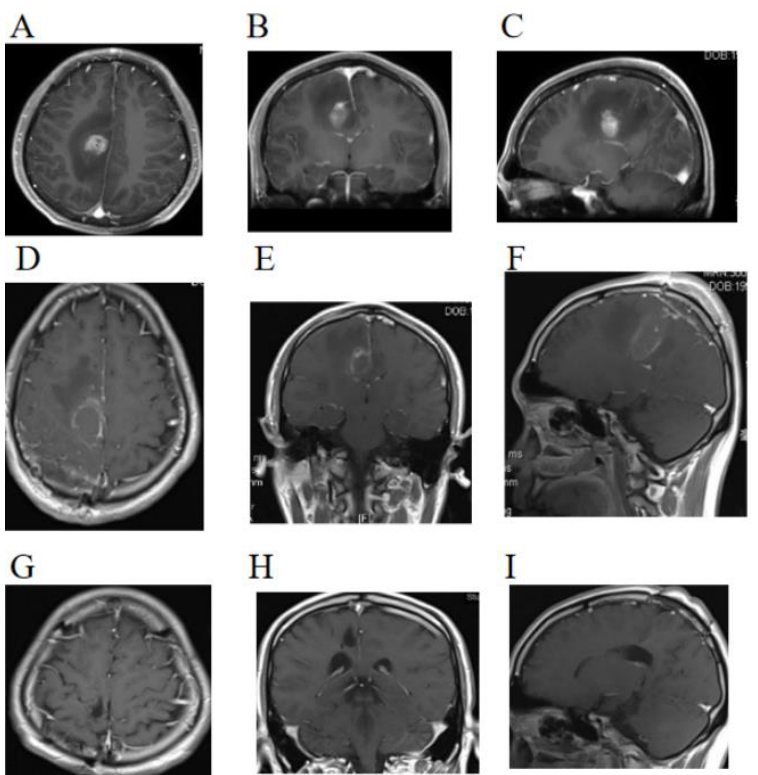
Figure 1. T1-weighted imaging of the brain. ( A – C ) Preoperative imaging revealed a mass in the right cingulate gyrus. ( D – F ) MRI 48 h after surgery showed no obvious tumor residue. ( G – I ) Images taken